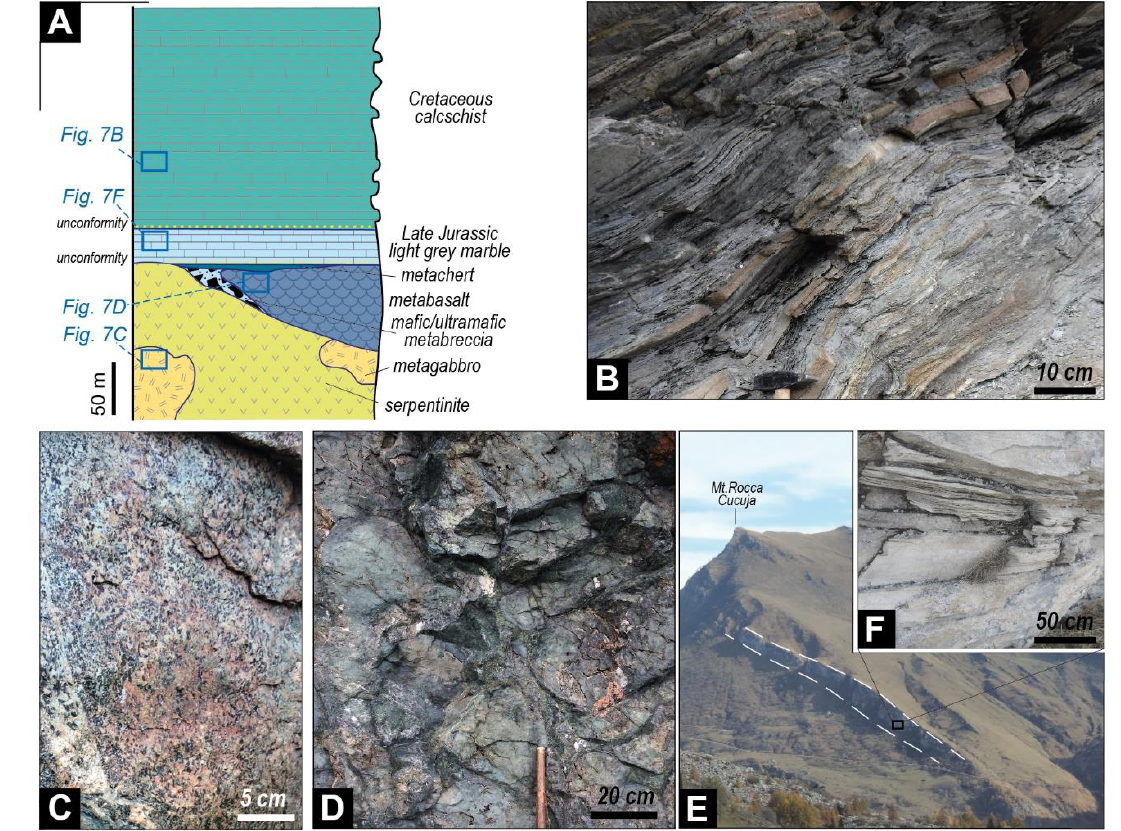
Figure 7. ( A ) Pre-Alpine stratigraphic columnar section of the Queyras Schistes Lustrès Complex (the stratigraphic location of the representative field images is shown); ( B ) Cretaceous calcschist consisting of interlayered light brown carbonate-rich and dark grey carbonate-poor layers (North-East of Mt.Rocca Cucuja); ( C ) massive coarse-grained metagabbro of Mg-Al rich composition mainly consisting of dark grey pyroxene and greenish white plagioclase (Mt. Rocca Pergo); ( D ) metabasalt retaining pillow-breccia structures (Mt. Rocca Pergo); ( E ) panoramic view of a tabular body (dashed white lines) of Late Jurassic whitish marble within the calcschist; ( F ) close-up view of the massive whitish marble and of the more foliated carbonate-rich